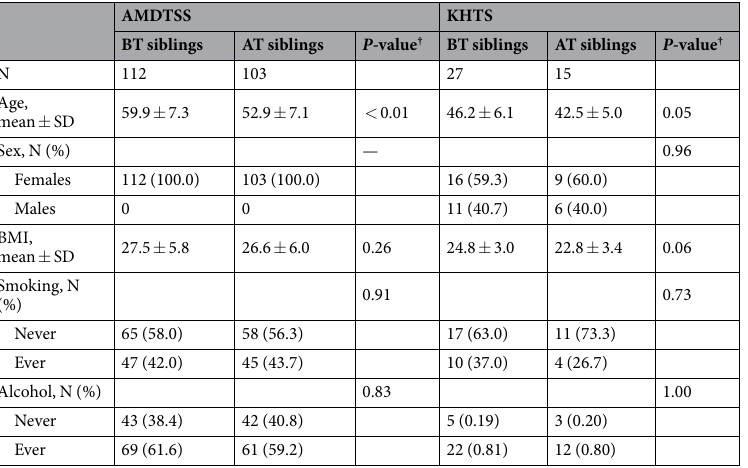
Table 1. Characteristics of BT and AT siblings from the AMDTSS and KHTS * . * BT: before twin birth; AT: after twin birth; AMDTSS: Australian Mammographic Density Twins and Sisters Study; KHTS: Korean Healthy Twin Study; SD: standard deviation. † P -value for compare the characteristic between BT and AT siblings within each study.